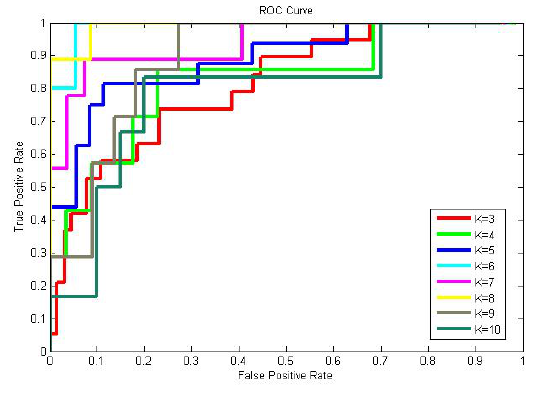
Fig. 15. ROC curves using the grid search for optimal parameters of C-SVM classifier for different K